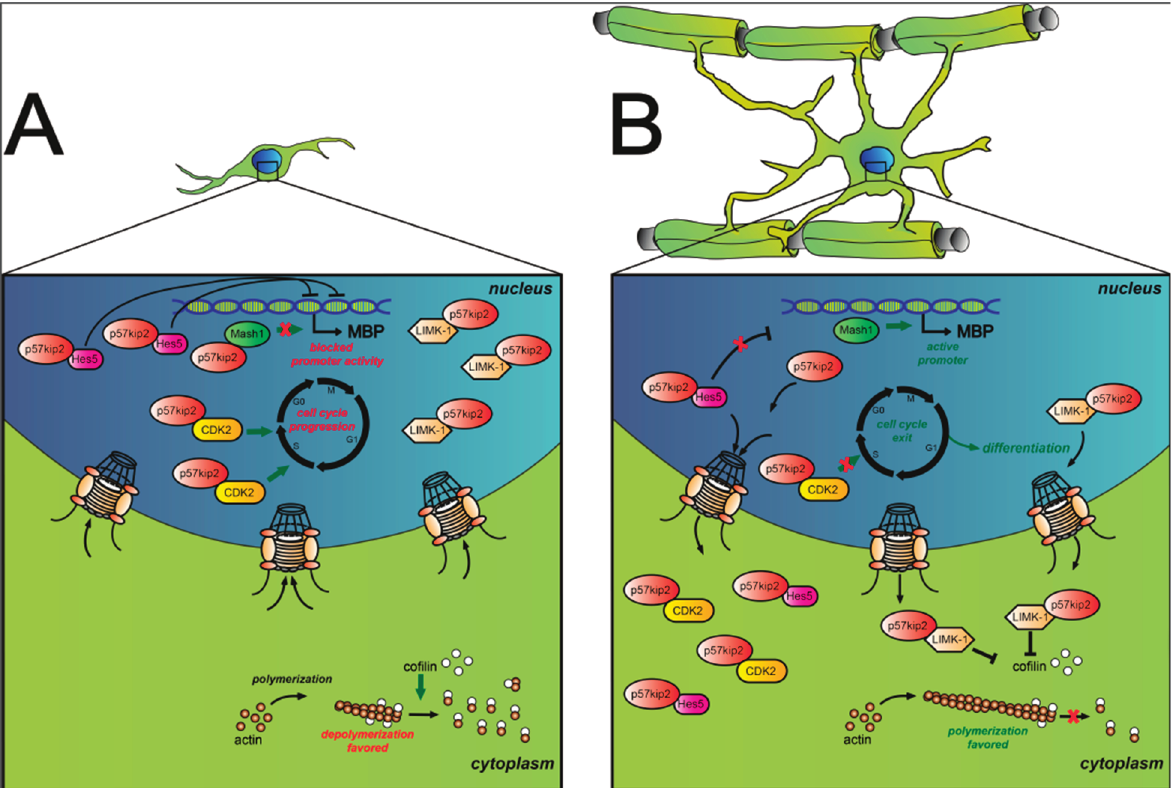
Figure 2. ( A ) In early stages of oligodendroglial precursor cell (OPC)